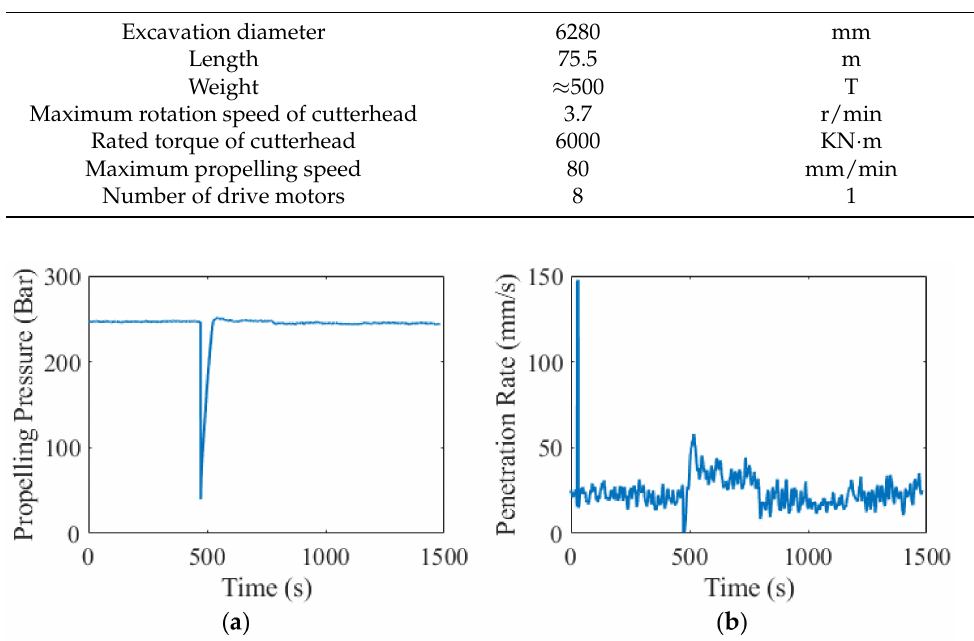
Figure 5. Some attributes with outliers: ( a ) propelling pressure and ( b ) penetration rate.